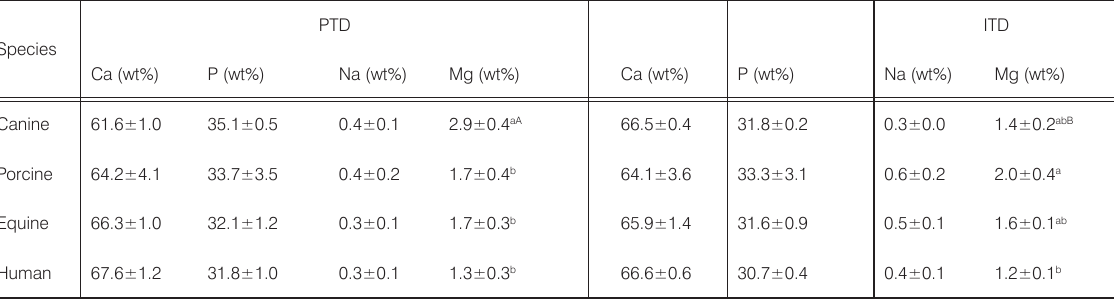
Table 3. Means ± standard deviations of element content (wt%) of canine, porcine, equine, and human peritubular dentin (PTD) and intertubular dentin (ITD).